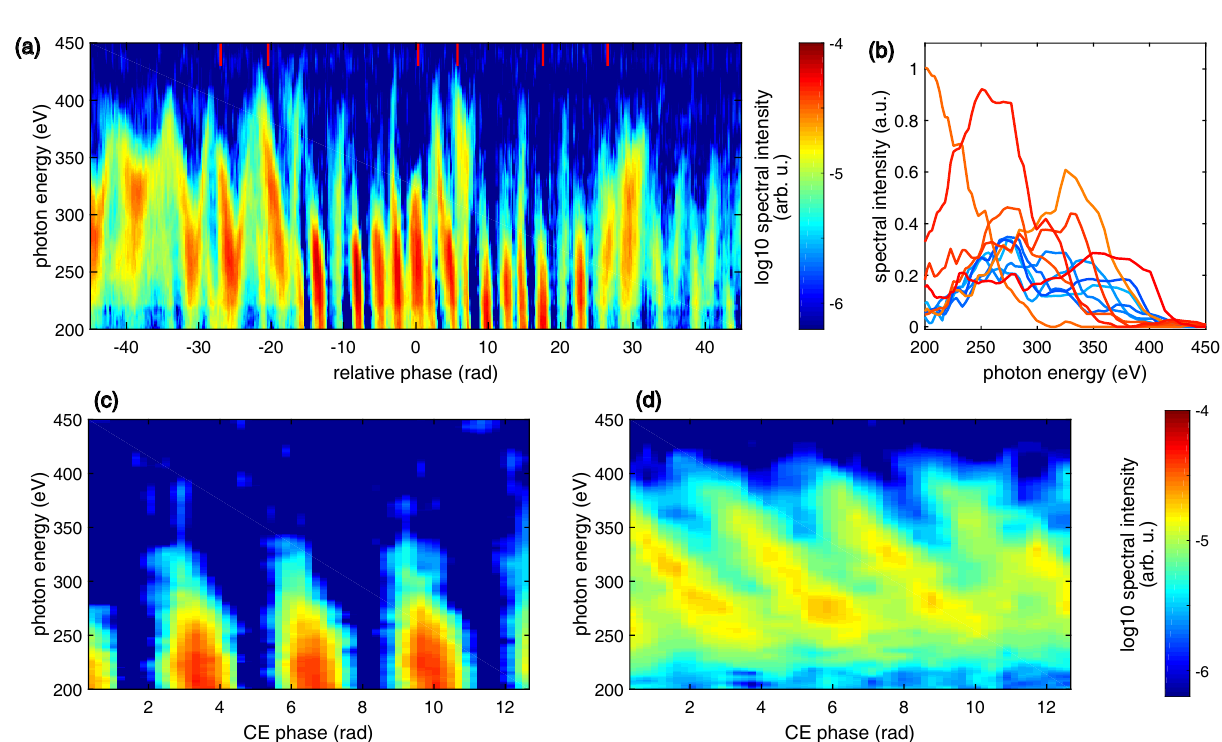
Figure 1. High-Harmonic spectra generated in helium with 10 bar of backing pressure and 2 seconds integration time. The spectra are Jacobi-corrected, transfer functions of grating and CCD are not applied. A 200 nm thick aluminum filter is used to block the IR. (a) Scan of the relative phase (RP) for a fixed CEP value, showing continua of various central photon-energies and bandwidths. (b) In red colour scale: selected HHG spectra corresponding to di ff erent RP values, marked with red ticks on the top of (a); in blue scale: IR-only HHG spectra corresponding to di ff erent CEPs covering a π range. (c) CEP scan for one particular RP value. (d) CEP scan of